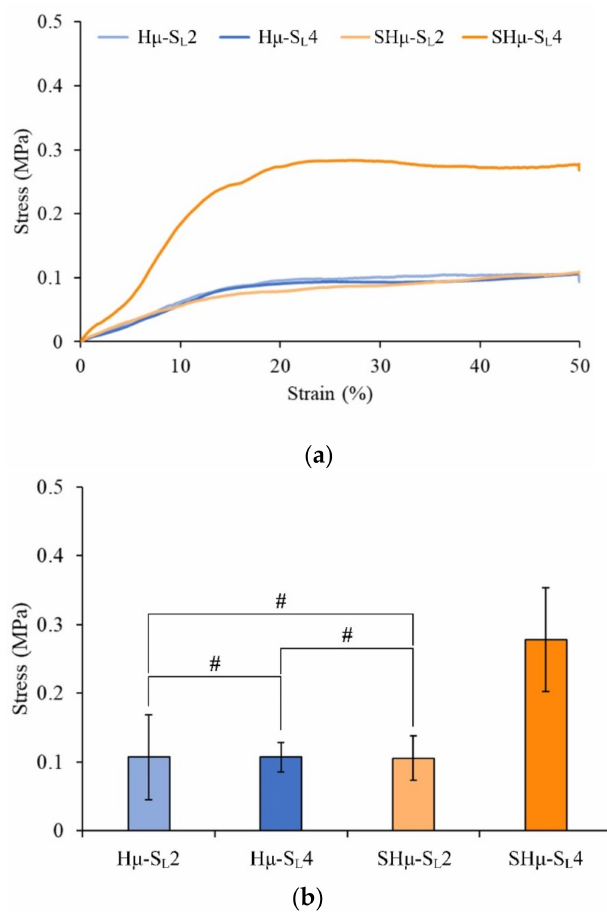
Figure 6. ( a ) Compressive stress–strain curves of different hydrogel scaffolds after cross-linking ( n = 20) and ( b ) the corresponding offset stress at 50% deformation ( n = 20). # indicates that the groups are not significantly different after comparison ( p >